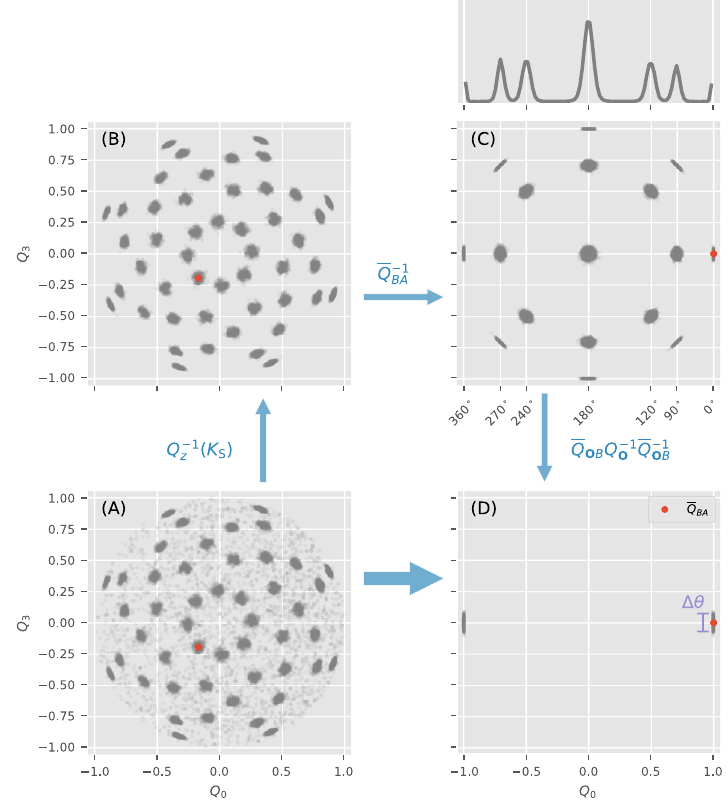
Figure 9. Collapsing the ADD of 500 sentinel patterns for a scatterer, whose diffraction volumes is centro- symmetric and has octahedral symmetry, into the fundamental domain: ( A – D ). Starting clockwise from ( A ), which shows a projection of the ADD onto two components of each quaternion ( Q = ( Q 0 , Q 1 , Q 2 , Q 3 ) ), we collapsed the points related by centro-symmetry (since 2D patterns have sufficiently low resolution) to obtain a sharper distribution in ( B ). The red disk throughout the panels represent the average quaternion Q AB of the ADD. In ( C ), we rotate the ADD such that Q AB = ( 1, 0, 0, 0 ) for clarity. The histogram of the ADD vs Q 0 is shown above panel ( C ), can sometimes reveal the flavor of symmetry in W . Finally, using the particle’s known symmetry group operations we can fold the ADD into the fundamental domain in ( D